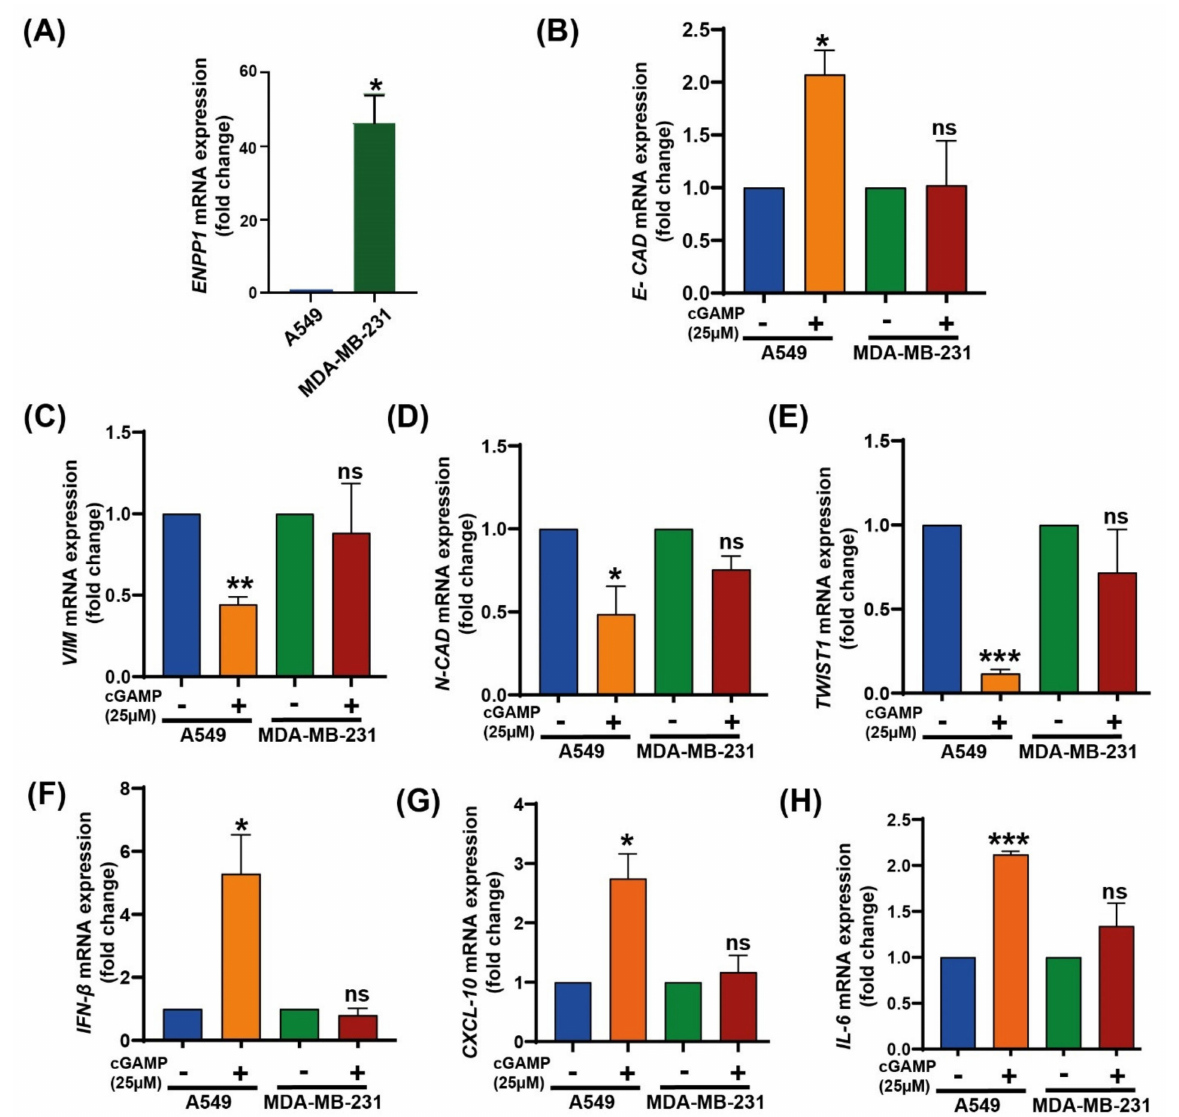
Figure 3. Effect of 2 (cid:48) 3 (cid:48) -cGAMP on EMT markers. ( A ) ENPP1 mRNA levels were quantified in A549 Dual™ and MDA-MB-231. Ct values of ENPP1 were normalized with respective Ct val- ues for GAPDH (normalized Ct). Relative fold change was plotted considering A549 Dual™ as 1 (n = 3). ( B – E ) A549 Dual™ and MDA-MB-231 cells were treated with 25 µ M 2 (cid:48) 3 (cid:48) -cGAMP for 24 h, and mRNA levels of various EMT markers were estimated using RT-PCR ( B ) E-CAD , ( C ) VIM , ( D ) N-CAD , and ( E ) TWIST1 (n = 3). ( F – H ) Inflammatory cytokine mRNA levels were also quantified in the same experiment ( F ), IFN- β , ( G ), CXCL-10 , ( H ), and IL-6 . The fold change values were plotted using GAPDH as endogenous control (n = 3). The p -values were calculated using paired Student’s t -test. * p < 0.05, ** p < 0.01, *** p < 0.001, ns: